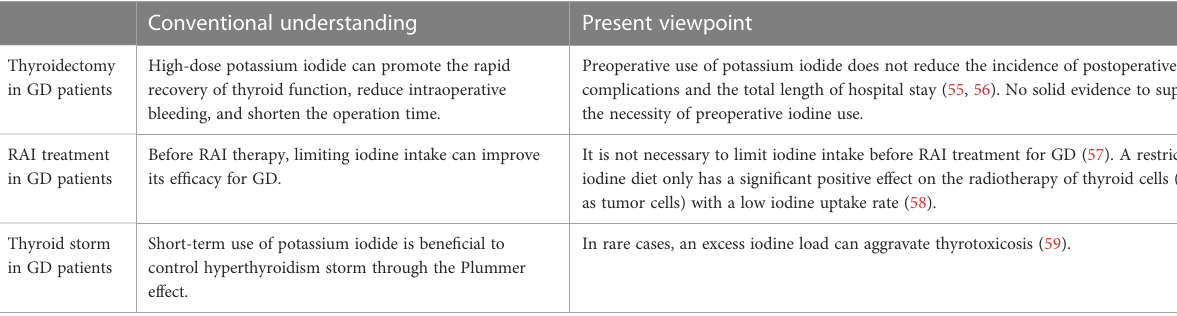
TABLE 2 The administration of potassium iodide under three special